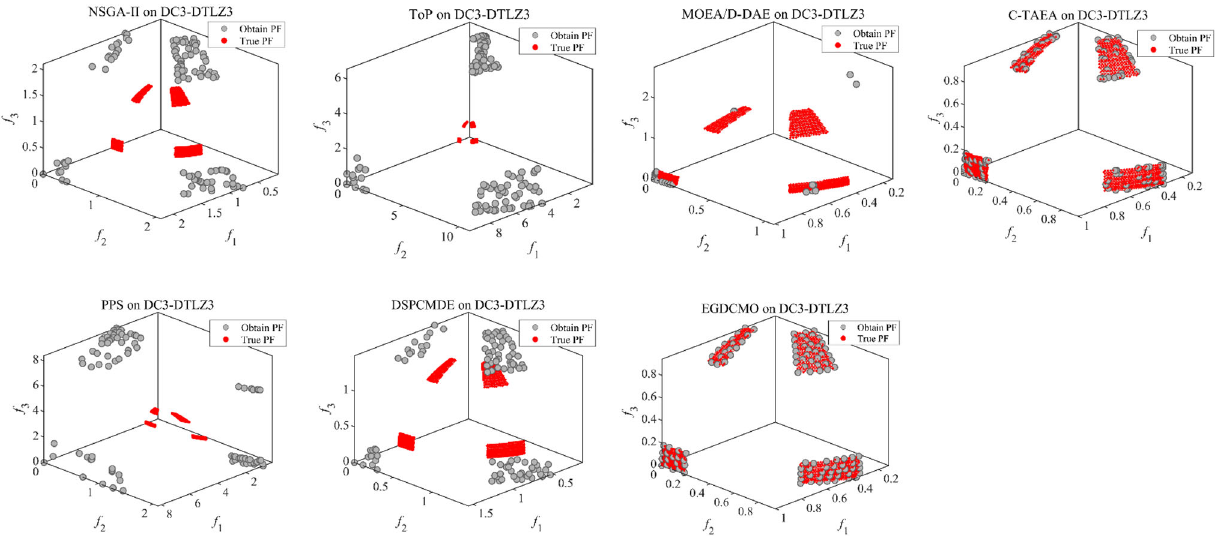
The best result in each row is highlighted. “N/A” indicates that no feasible solution is found